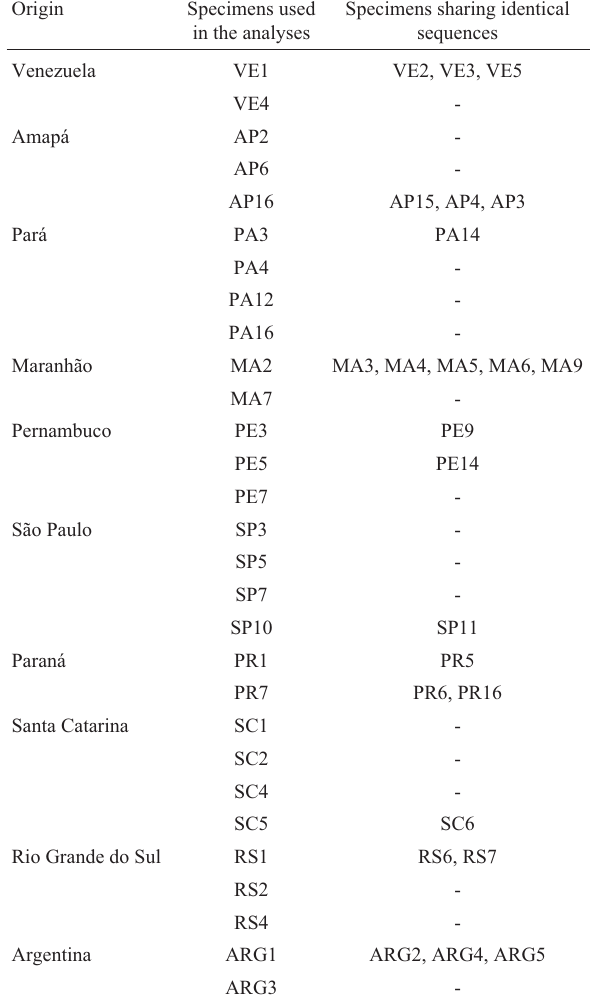
Table 2 - Specimens of Macrodon ancylodon whose cytochrome b was